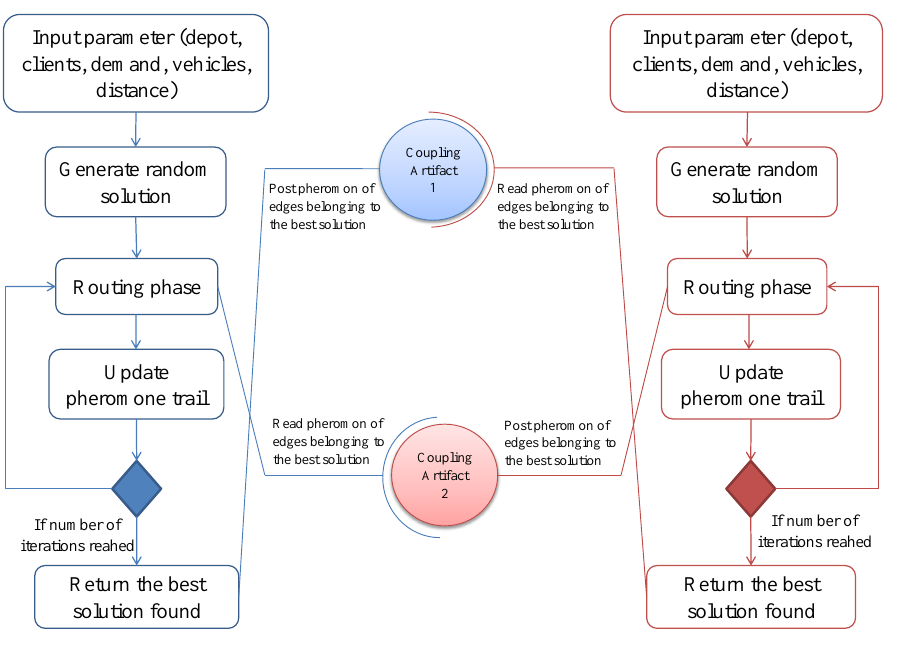
Figure 4. Behavior of two models in interaction.